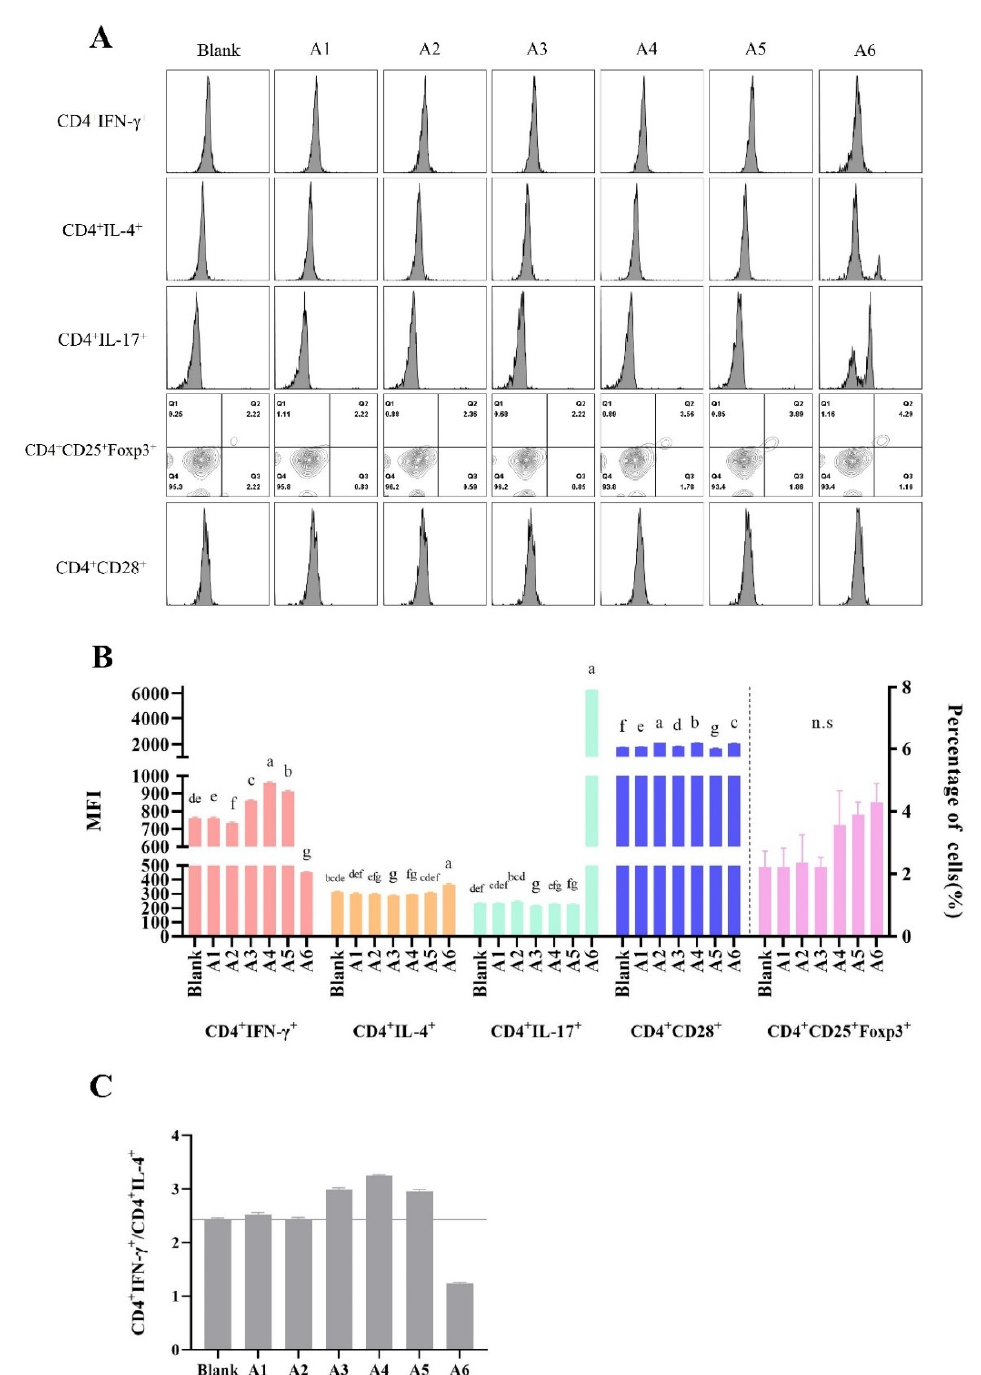
Figure 5. Peptides BLG 1–14 , BLG 40–60 , BLG 82–101 , and BLG 123–139 directed differentiation of activated MLN-CD4 + T lymphocytes towards a Th1 phenotype in the peptide–MLN cell-co-culture assay. ( A ) The histogram results of CD4 + IFN- γ + , CD4 + IL-4 + , CD4 + IL-17e + , and CD4 + CD28 + , and the contour plot